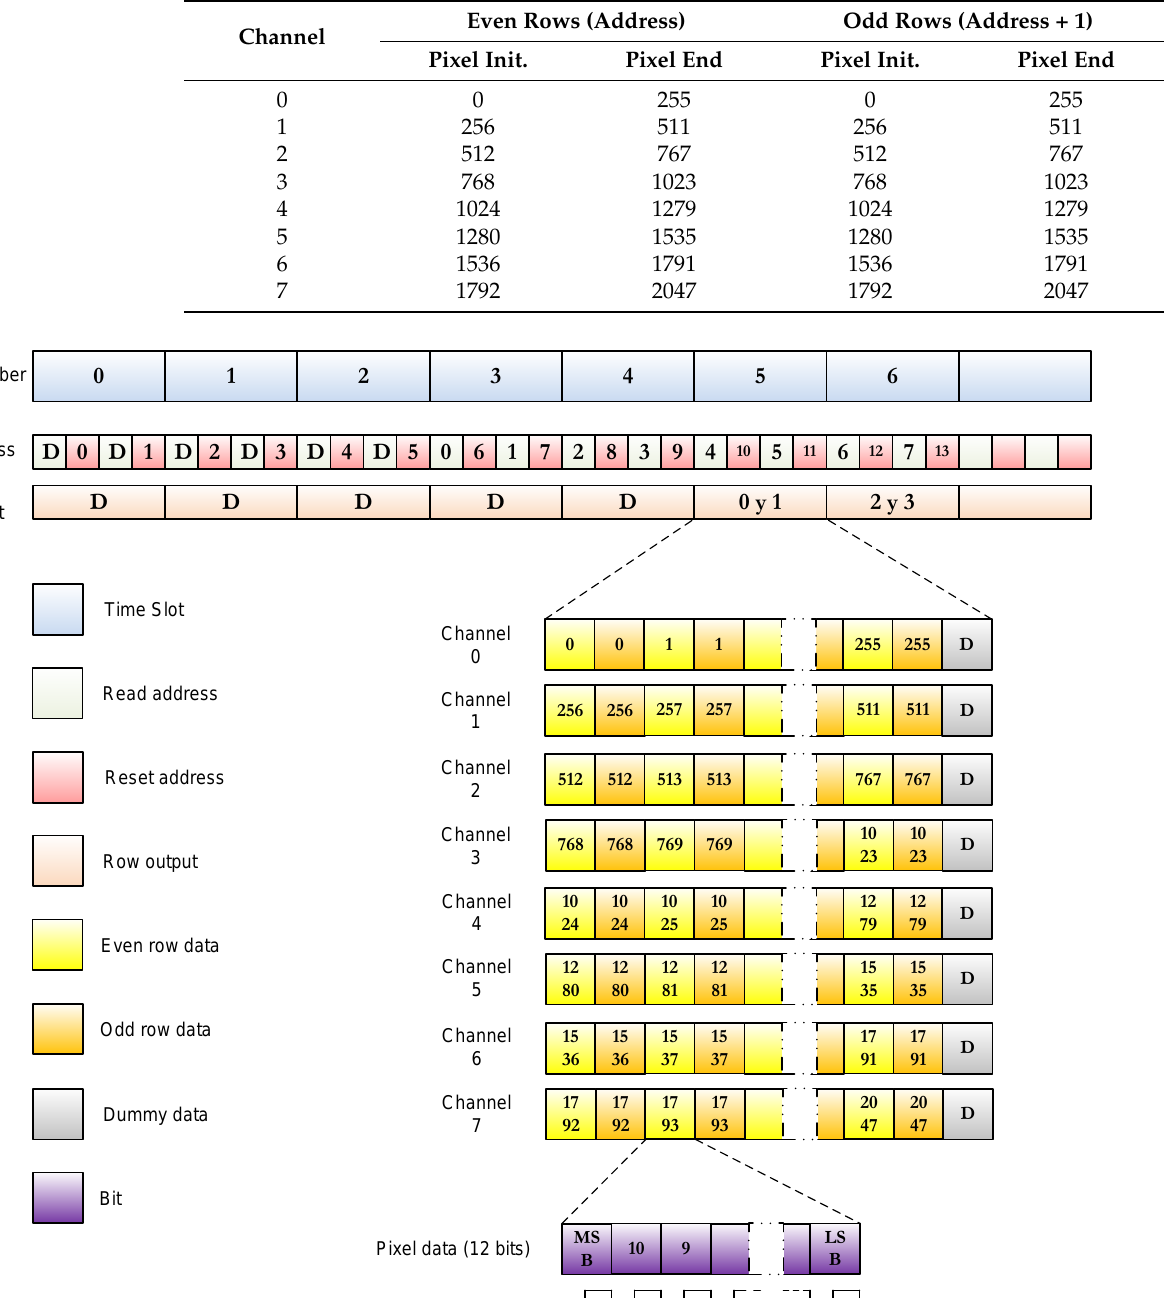
Table 2. Data output in STD mode.